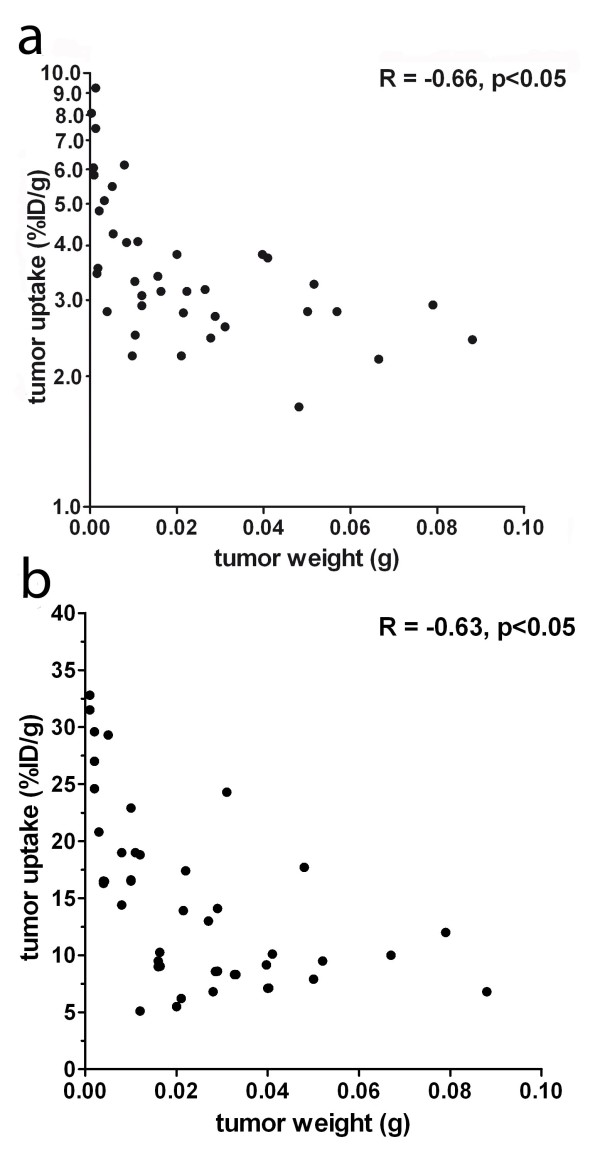
Correlation between tumor uptake of 125I-TF2 (A) and 68Ga-IMP288 (B) and tumor size. (Spearman's rho = -0.66, p < 0.05 and Spearman's rho = -0.63, p < 0.05, respectively.)